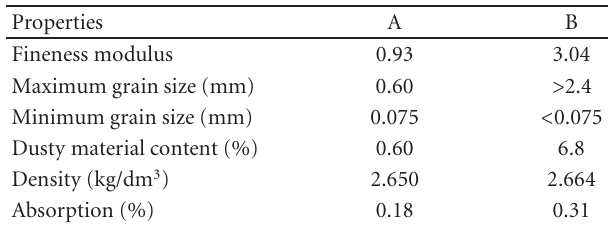
Table 1: Physical properties of the